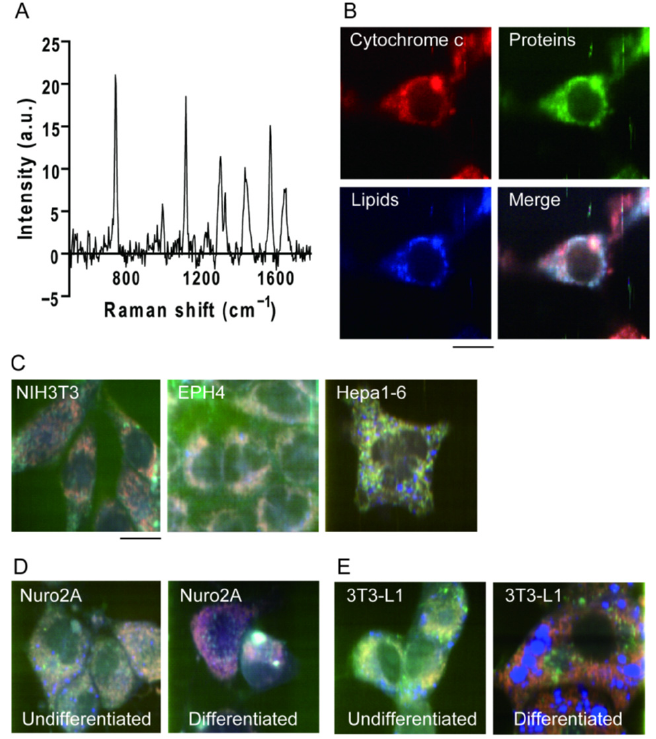
Figure 1. Raman spectra from living cells. ( A ) Typical Raman spectrum from a living NIH3T3 cell. ( B ) Pseudo-color Raman image of NIH3T3 cells. Cells were colored by peak values at 753 cm − 1 (cytochrome c; red), 1686 cm − 1 (proteins, green) and 1340 cm − 1 (lipids; blue). Scale bar, 10 μ m. ( C ) Raman image of NIH3T3 cells (left), EPH4 cells (middle), and Hepa1-6 cells (right). Scale bar, 10 μ m. ( D , E ) Raman image of Neuro 2A ( D ) and 3T3-L1 ( E ) cells before (left) and after (right) differentiation. Scale bar, 10 μ m. Reproduction from reference [9].